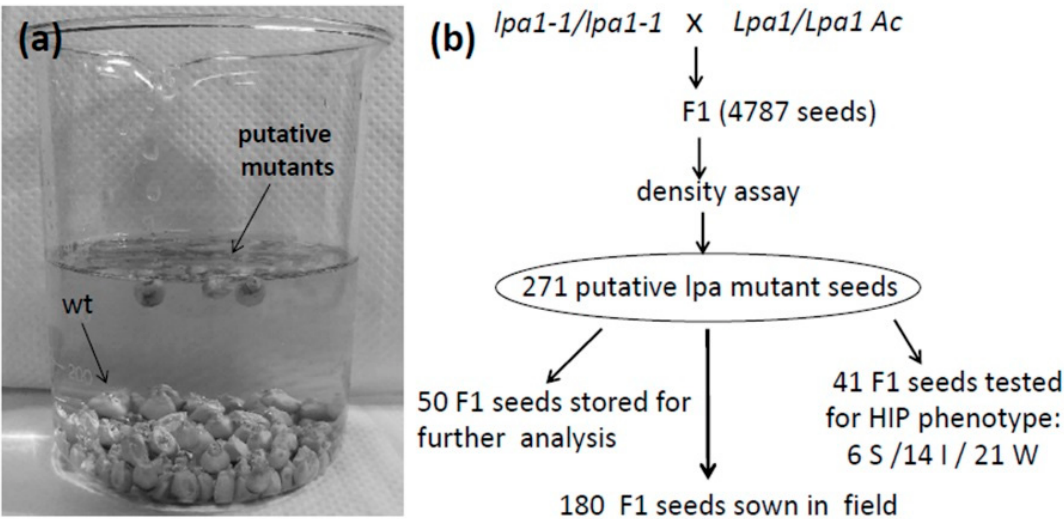
Figure 2. ( a ) Density assay used to isolate new lpa1 mutants: in the sucrose solution lpa1 mutant seeds float and wild type seeds stay on the bottom of the beaker. ( b ) Scheme of the experimental plan used to generate and to screen the F1 mutagenized population.